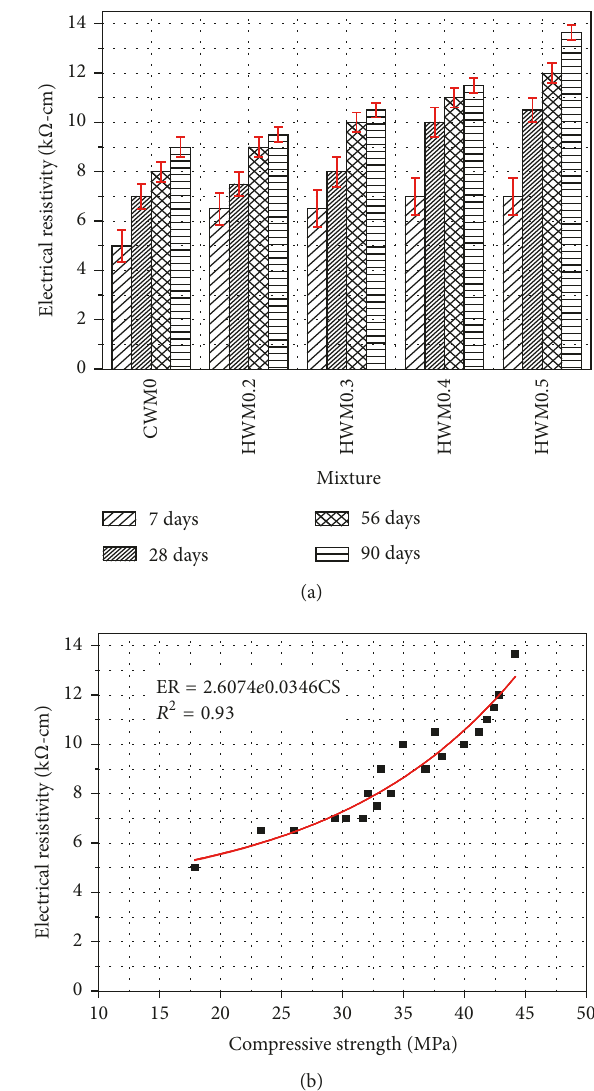
Figure 6: (a) Electrical resistivity of mortar mixtures at various ages. (b) Relationship between compressive strength and electrical resistivity of different mortar